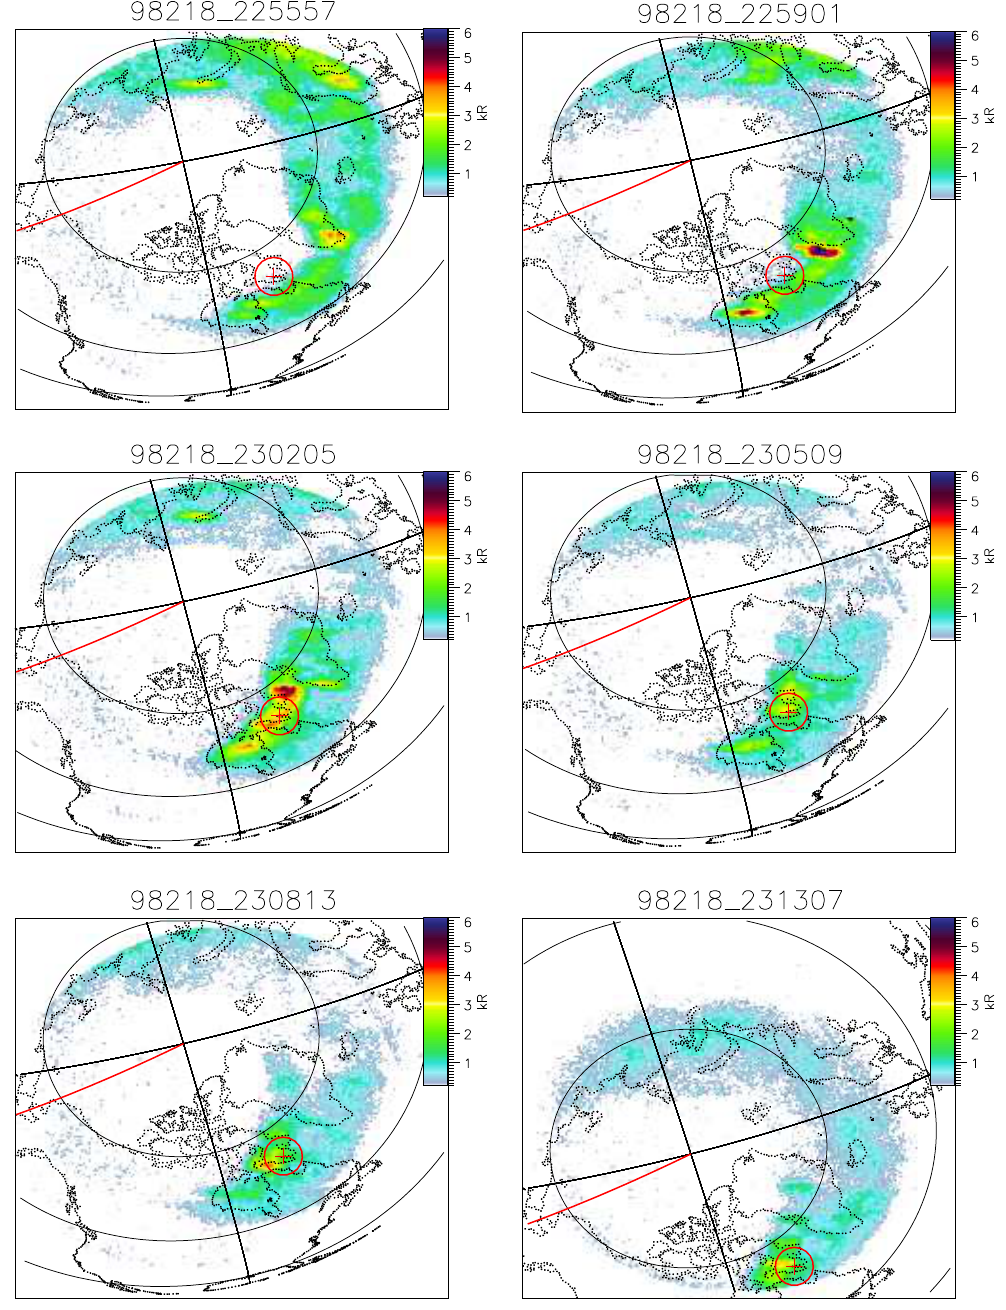
Fig. 5. UVI images with a geographic coordinate grid showing 50 ◦ and 70 ◦ latitude. The images are 36 s integrations in the LBHl band with time stamps marking the beginning of this interval. The colour code gives the emission intensity. The location of Iqaluit station is marked with a red cross and a circle. The latter gives the size of the region for which spectral parameters are derived. The noon meridian is shown with a red